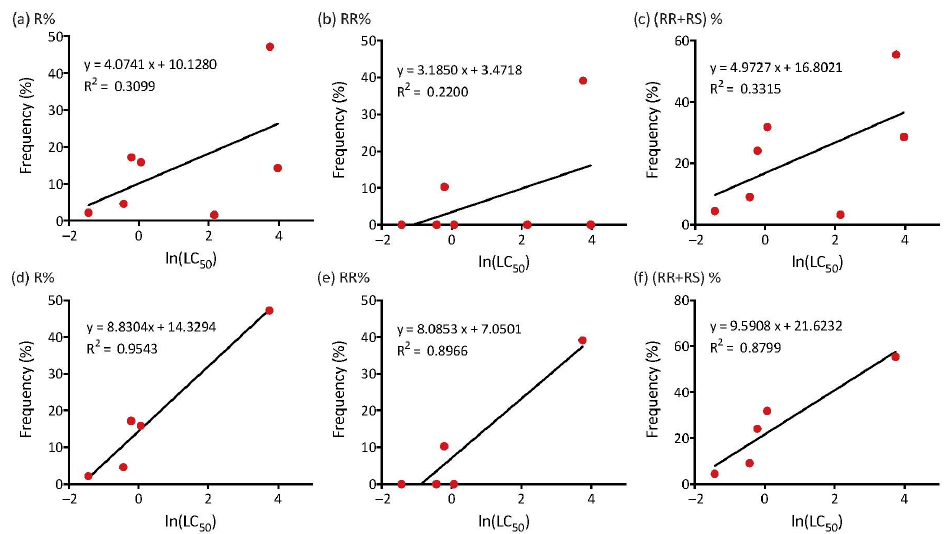
Figure 4. Regression between (ln) LC 50 and the frequencies of ( a ) the resistant allele, ( b ) RR resistant genotype and ( c ) the sum of homozygous and heterozygote genotypes with the resistant G275E mutation across all populations tested. We have also provided the regressions when the BJDJ2020 and BJHD2021 populations are excluded ( d – f ) .